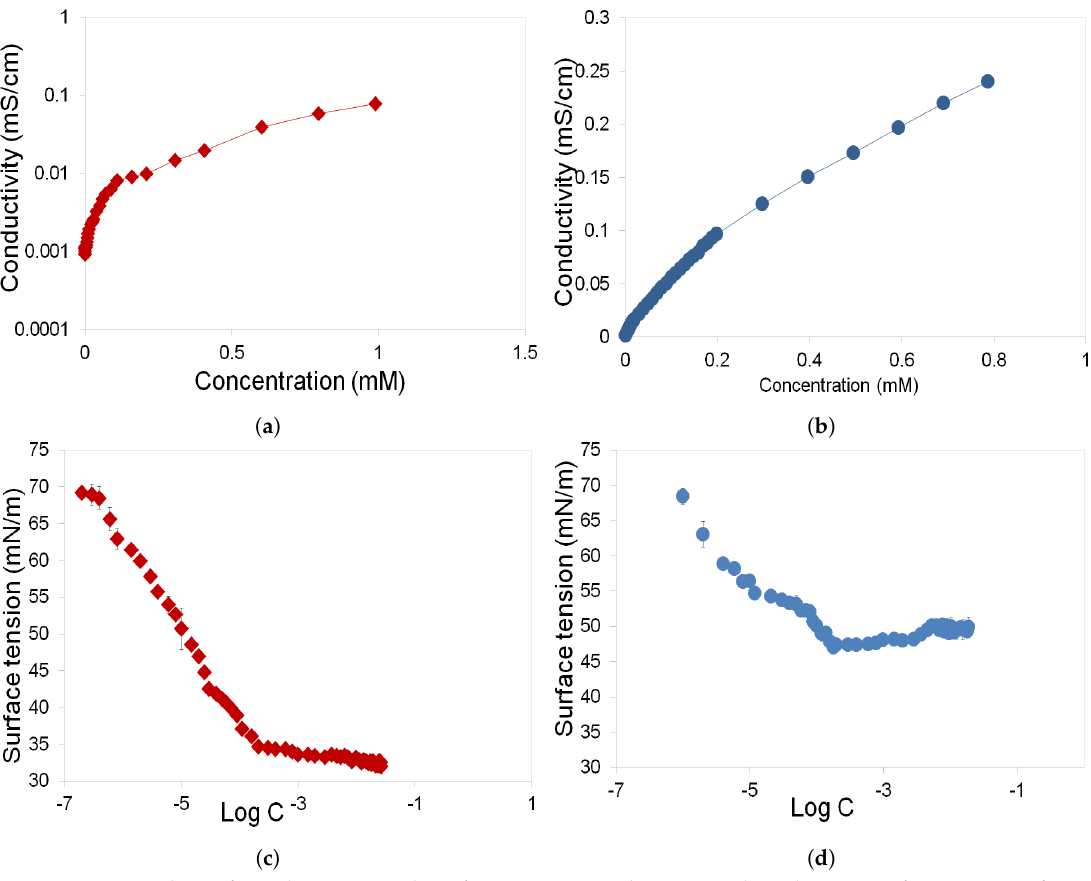
Figure 2. Plots of conductivity and surface tension isotherms used to determine free energy of micellisation and excess surface concentration for: rhamnolipid ( a , c ) and Greenzyme ( b , d